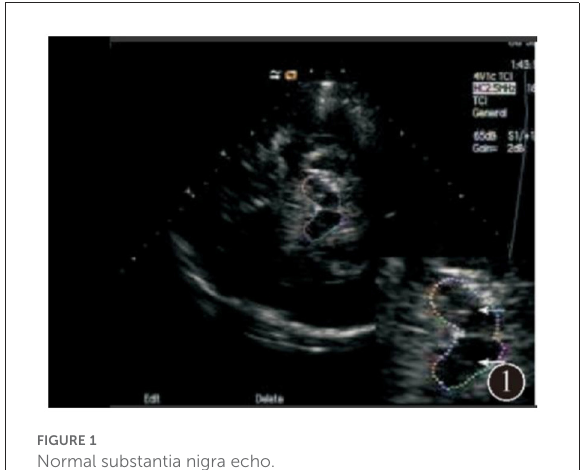
FIGURE1 Normal substantia nigra